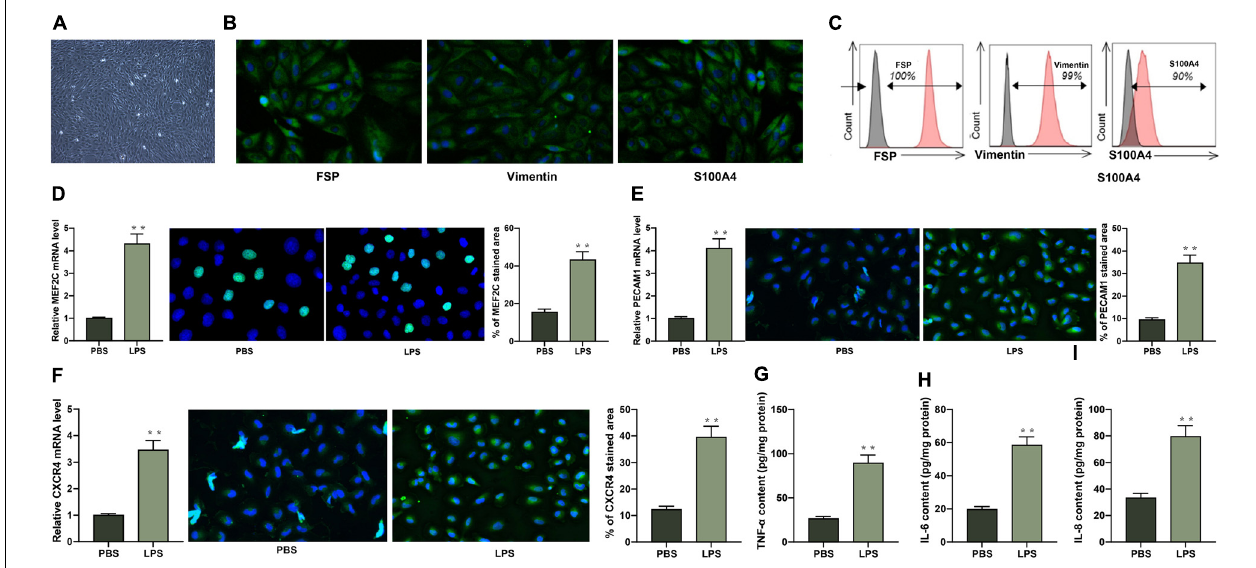
FIGURE 3 | PECAM1 and CXCR4 are highly expressed in LPS-treated HDPFs. (A) Morphology of the HDPFs observed under the microscope. (B) Expression of the HDPF-specific biomarkers determined by immunofluorescence staining. (C) Positive expression of HDPF-specific biomarkers examined by flow cytometry. (D–F) mRNA and protein expression of MEF2C. (D) PECAM1 (E) , and CXCR4 (F) in cells examined by RT-qPCR and immunofluorescence staining, respectively. (G–I) , secretion of TNF- α , IL-6, IL-8 in cells determined using ELISA kits. Data were collected from three individual experiments and expressed as mean ± SD. Data were analyzed by unpaired t -test. ** p < 0.01 vs. PBS.